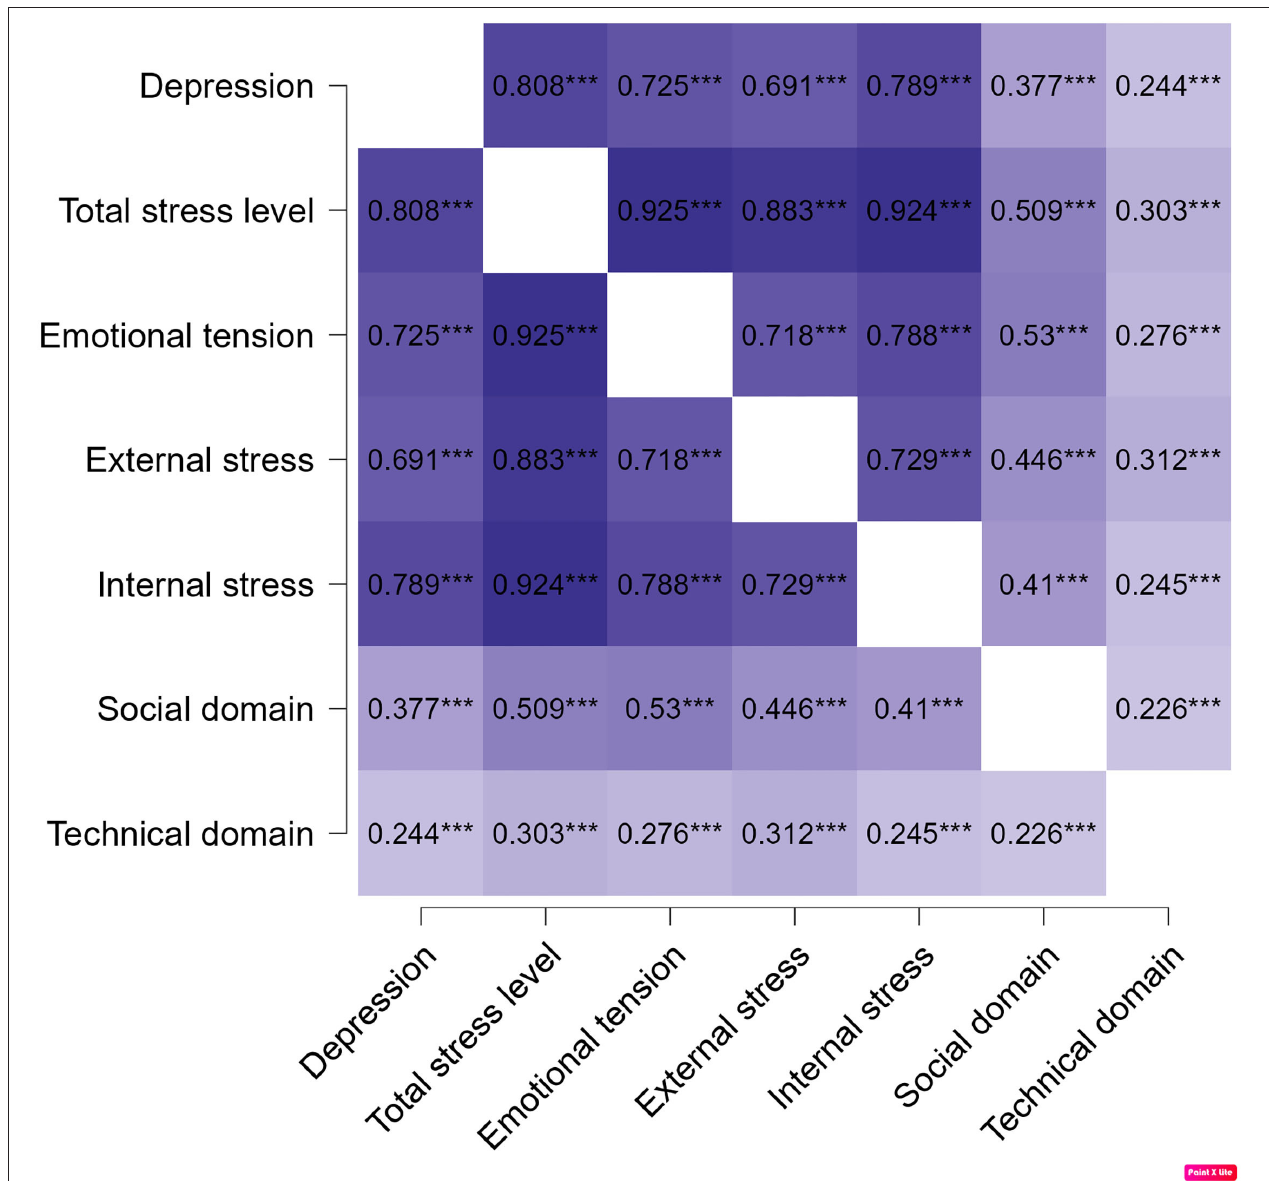
FIGURE 2 | Correlation heatmap for depression, stress level and stress domains.